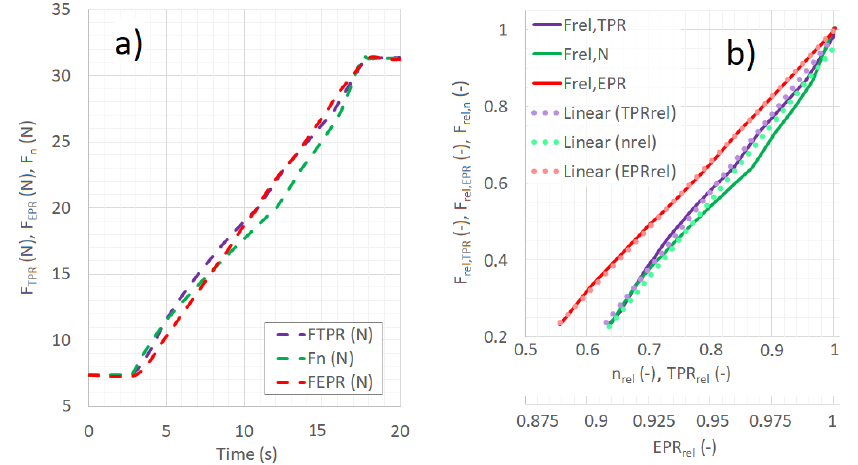
Figure 7. Effect of slowly rising control parameters on thrust output: ( a ) time series; ( b ) correlation between different control parameters and